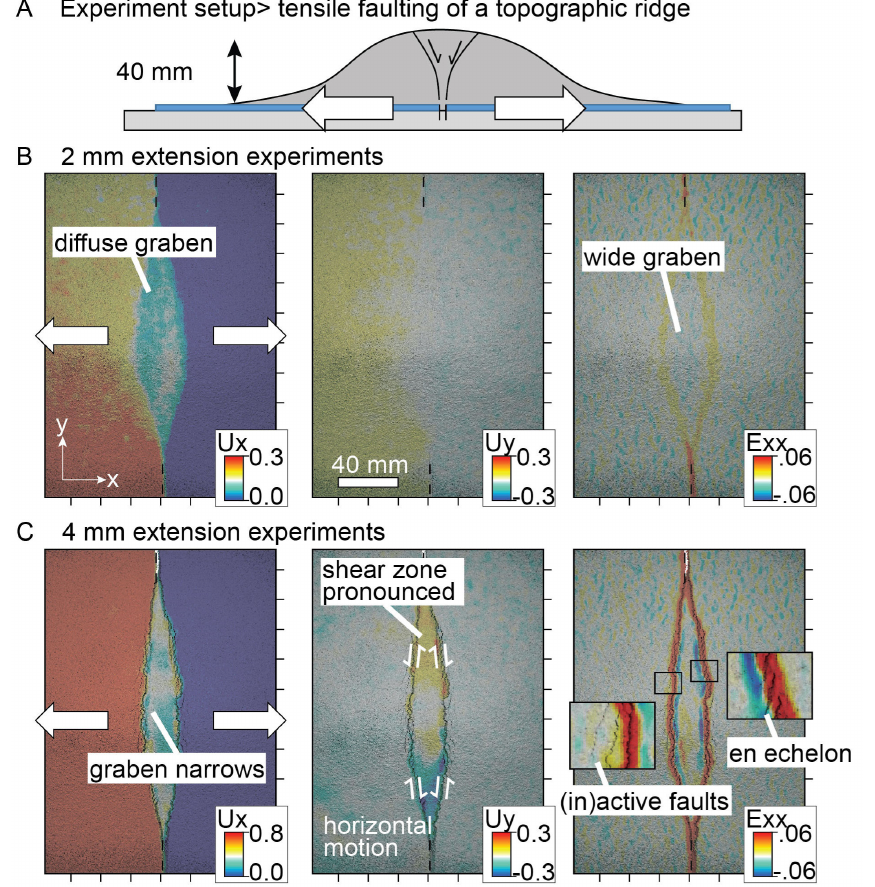
Figure 7: Modelling results on evolution of lens-shaped fractures. [A] Experimental setup, showing that a topographic ridge 40 mm high and wide, 140 mm wide (in y-direction) and 300 mm long (elongated in x-direction of the experiments) was subject to tensile faulting at the base. [B] After 2 mm of extension, horizontal displacement in x-direction (Ux) shows diffuse graben. Displacement in y-direction (Uy) shows no relevant deformation. Strain in x-direction (Exx) reveals fault locations. [C] After 4 mm of extension, faults become more clear, the graben narrows, Uy shows strike slip movement, and Exx reveals the presence of en-echelon faults and inactive faults in the outer